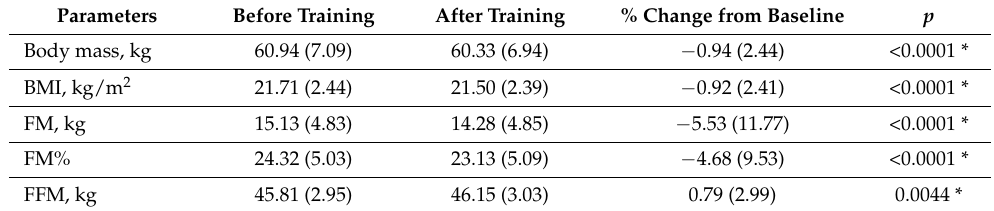
Table 1. Changes in body composition in 126 women during a 12-week aerobic training